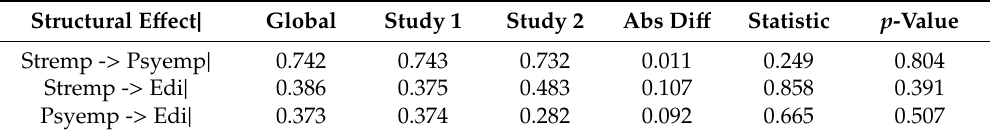
Table 6. Multigroup comparison (organizations)—Bootstrap t-test.